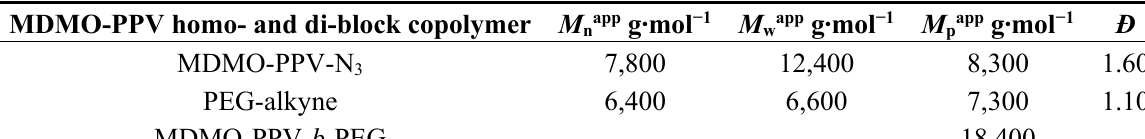
Table 6 . Molecular weights and Đ for the homopolymers and conjugated MDMO-PPV- b -PEG block copolymer .